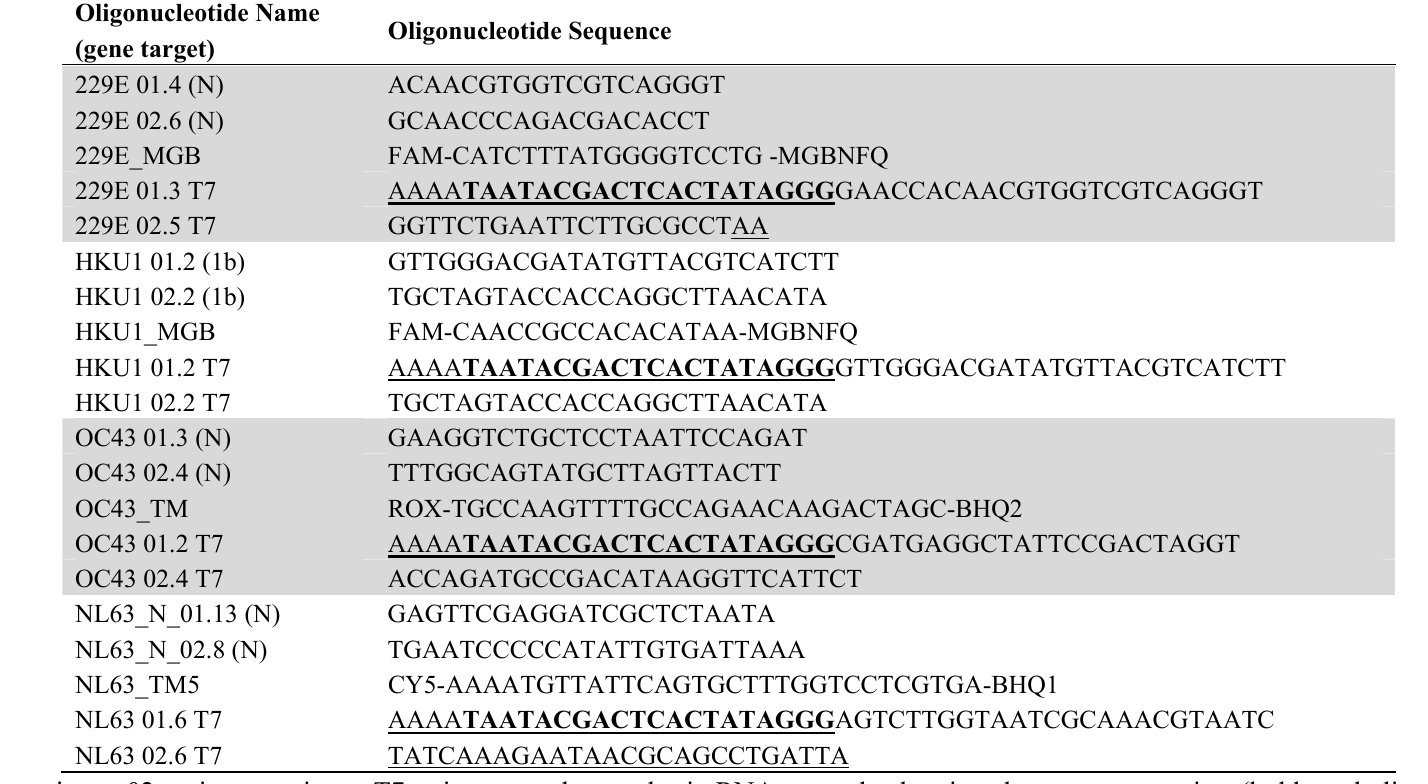
Table 1. Oligonucleotide primers and probes used for HCoV